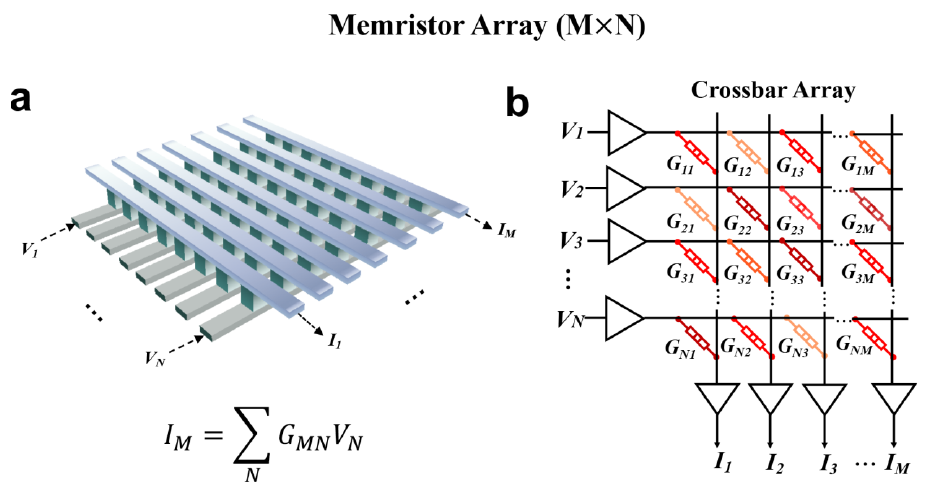
Figure 5. The memristor arrays of M × N for matrix-vector multiplication. Schematic of a memristor crossbar ( a ) arrays and ( b ) circuit. The voltage sequences (1 × N) are applied to the arrays to multiply by the conductance matrix G (N × M) to achieve MVM operation. According to Ohm’s law and Kirchhoff’s equations, the element I (1 × M) is output in one step by listing.